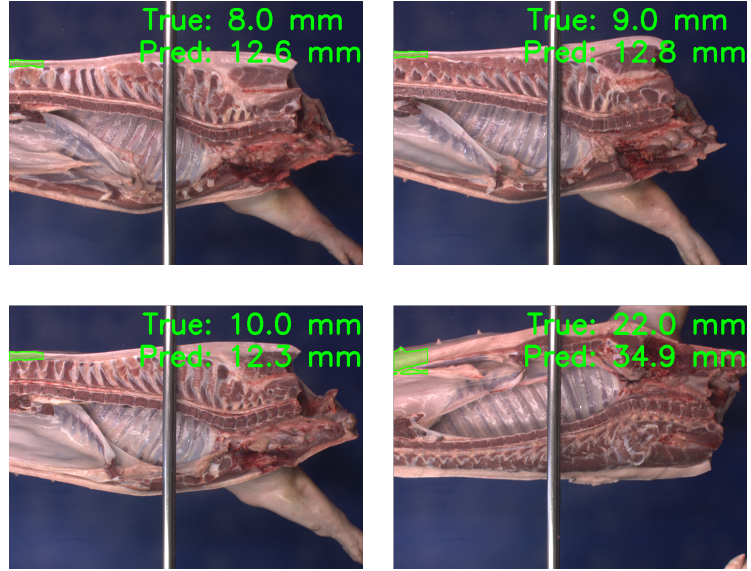
Figure 6. Failure examples of BTENet.